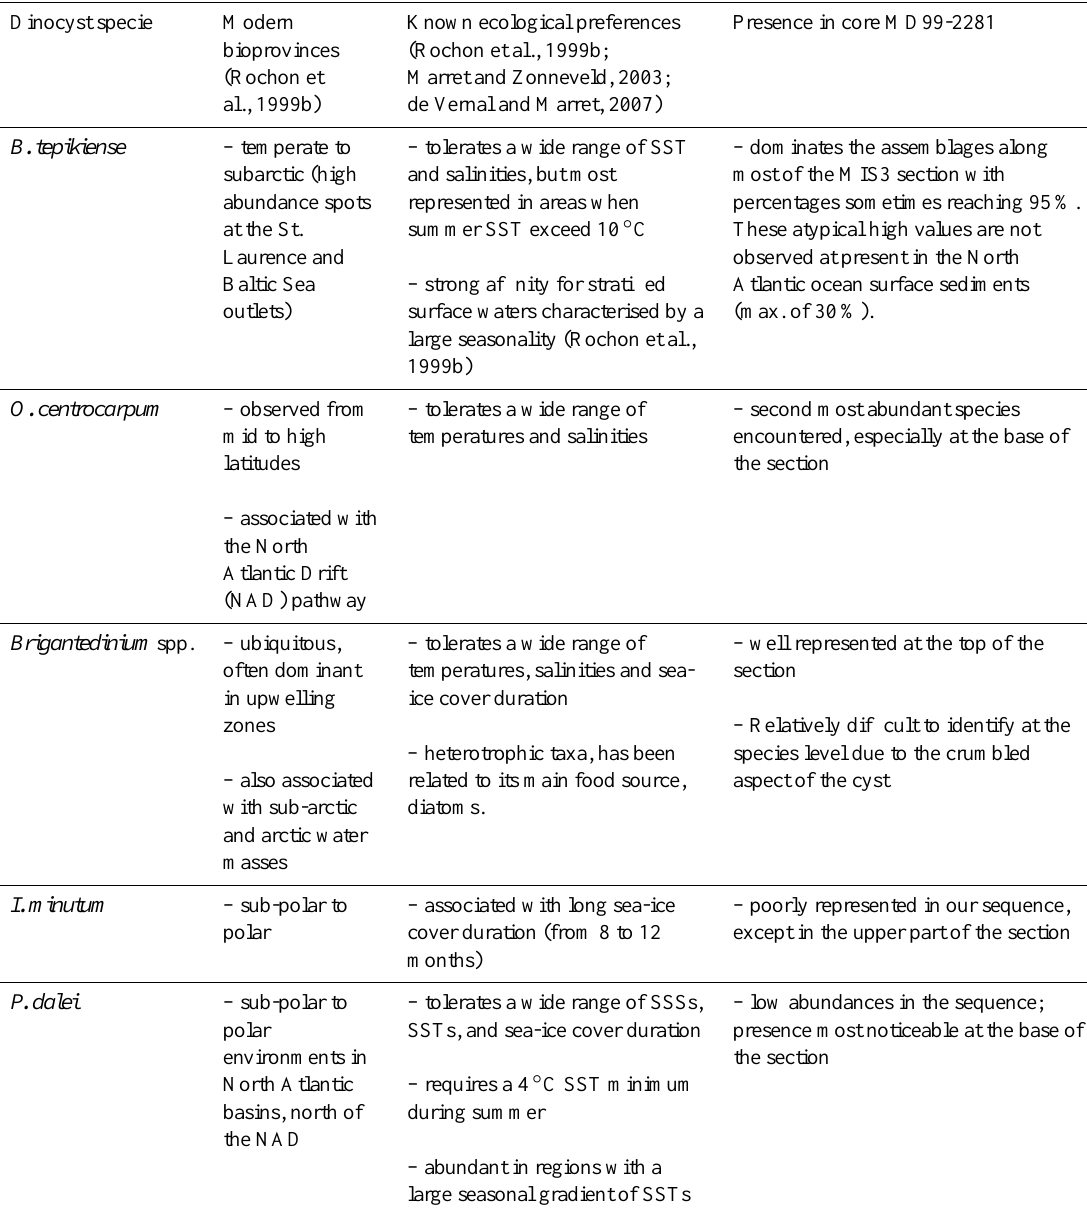
Table 2. Summary of the ecology of the main species recorded over the studied section of core MD99-2281. Dinocyst